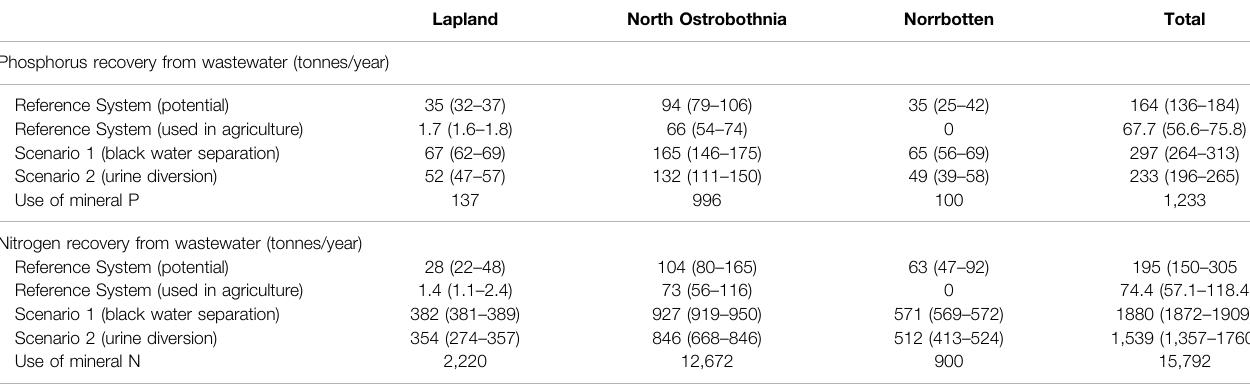
TABLE 5 | Phosphorus and nitrogen recovery potential in the studied regions. The average followed by maximum and minimum values (in parentheses) regarding the recovery potential of different treatment processes and residual streams. Extracted from available studies ( Table 3 ) and compared to the use of mineral fertilizers. Lapland North